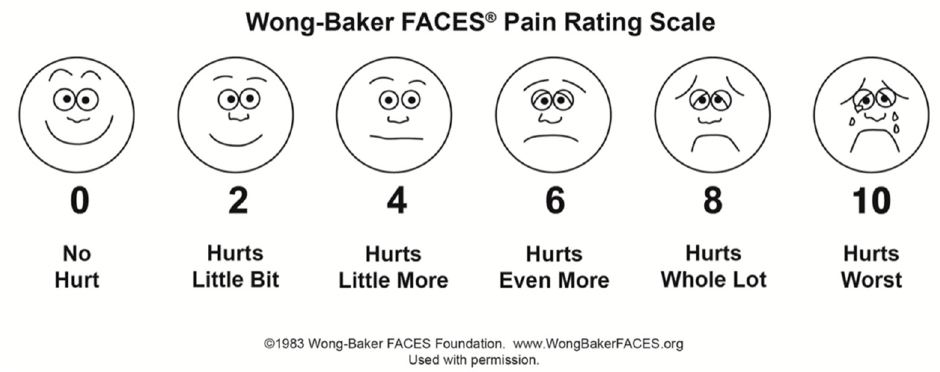
Figure 1. Wong–Baker FACES Pain Rating Scale